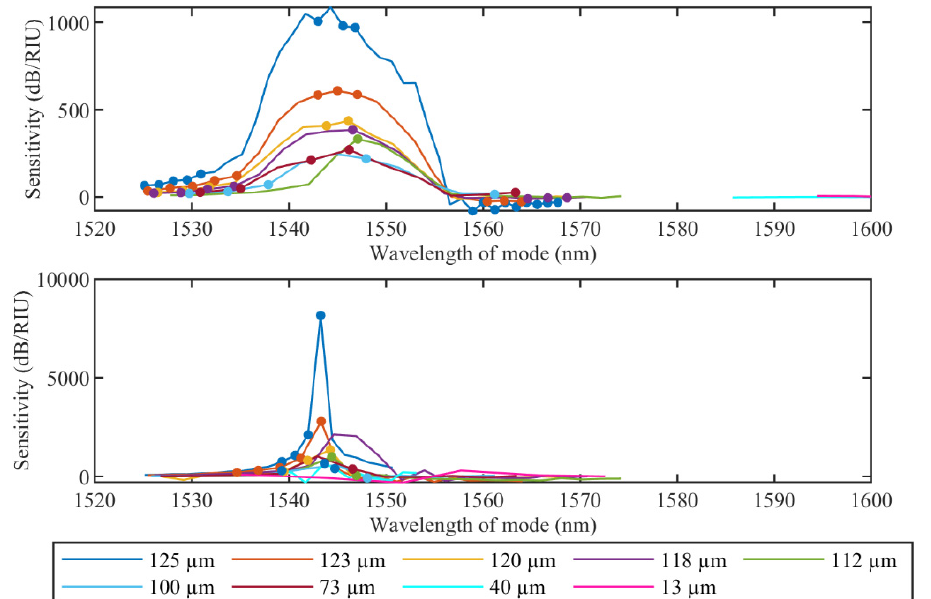
Figure 7. Evolution of the amplitude sensitivity for the high RI range from 1.33679 RIU to 1.37078 RIU